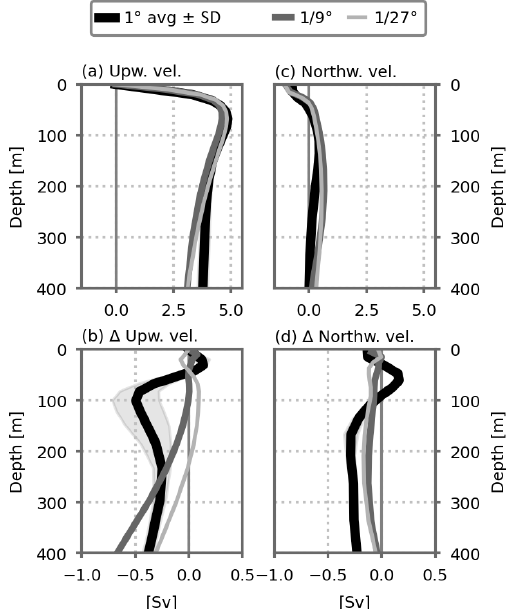
Figure 6. Vertical profiles of (a) the northward and (c) upward wa- ter transport (in Sv) entering the model’s subpolar box (dashed hor- izontal black lines in Fig. 3) in the preindustrial control simulations for each resolution. (b, d) Changes in these profiles between the cli- mate change and preindustrial control simulations. The thick black lines show the average of the five 1 ◦ configurations. Shading indi- cates ± 1 standard